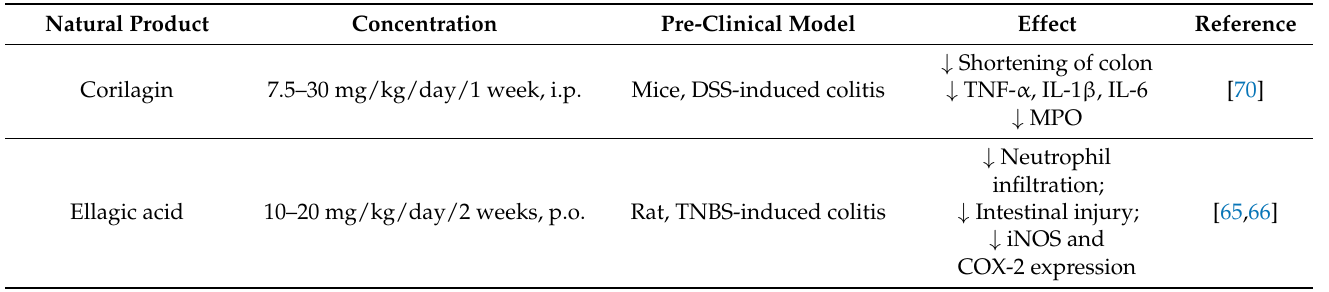
Table 3. Collection of recent articles concerning the biological activity of hydrolyzable tannins and their metabolites in IBD